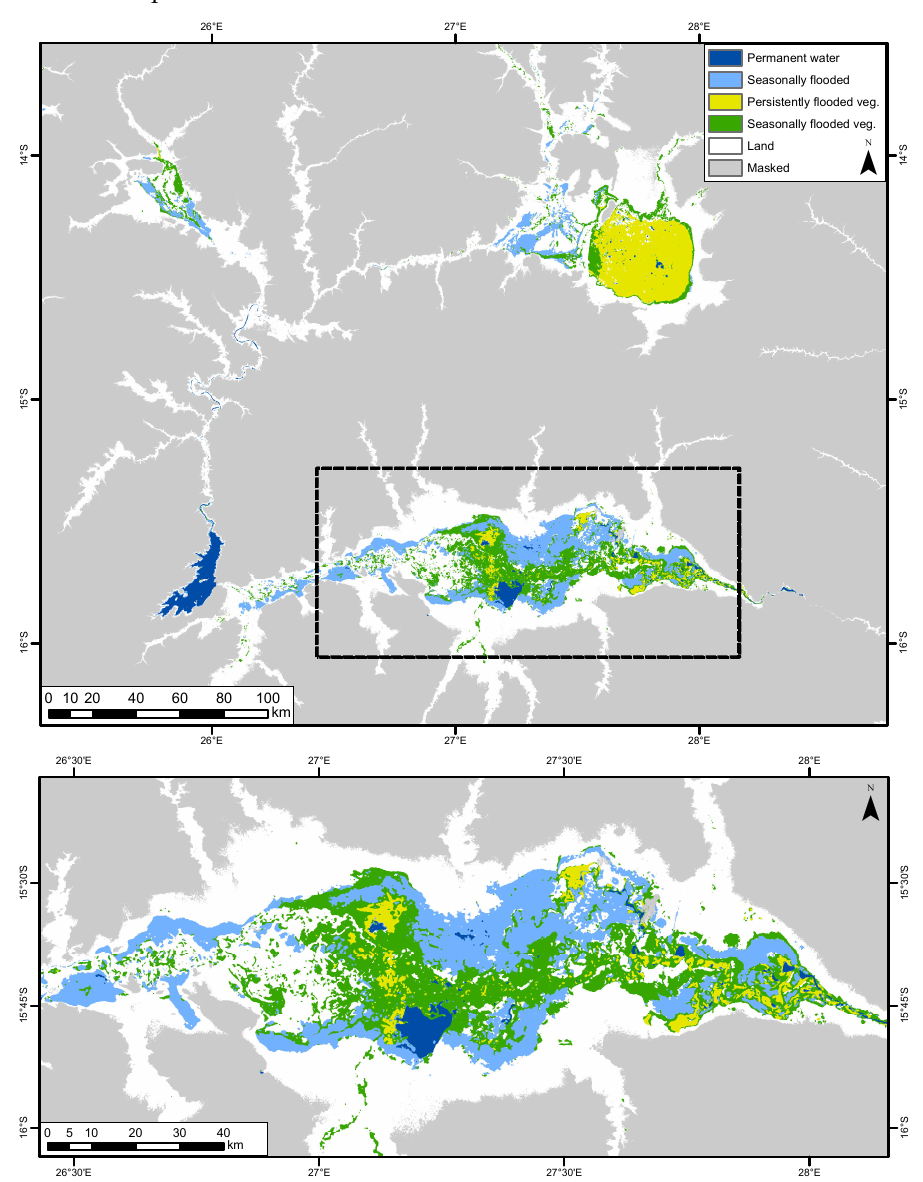
Figure 9. Result of wetlands classification for the entire study area ( top ) and the Kafue Flats ( bottom